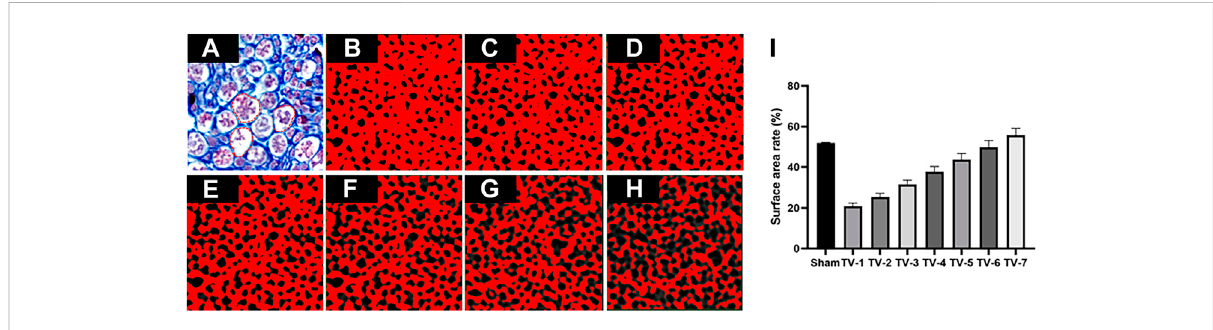
FIGURE 3 RepresentativeTVsusedtosegmenteECMmicro-CTimages. (A) Masson ’ strichromestainingandbinaryimageobtainedbyapplyingaTVof (B) 25, (C) 26, (D) 27, (E) 28, (F) 29, (G) 30 and (H) 31. (I) Surface rate results. The red dotted line represents the pore of endoneurium. n = 3.